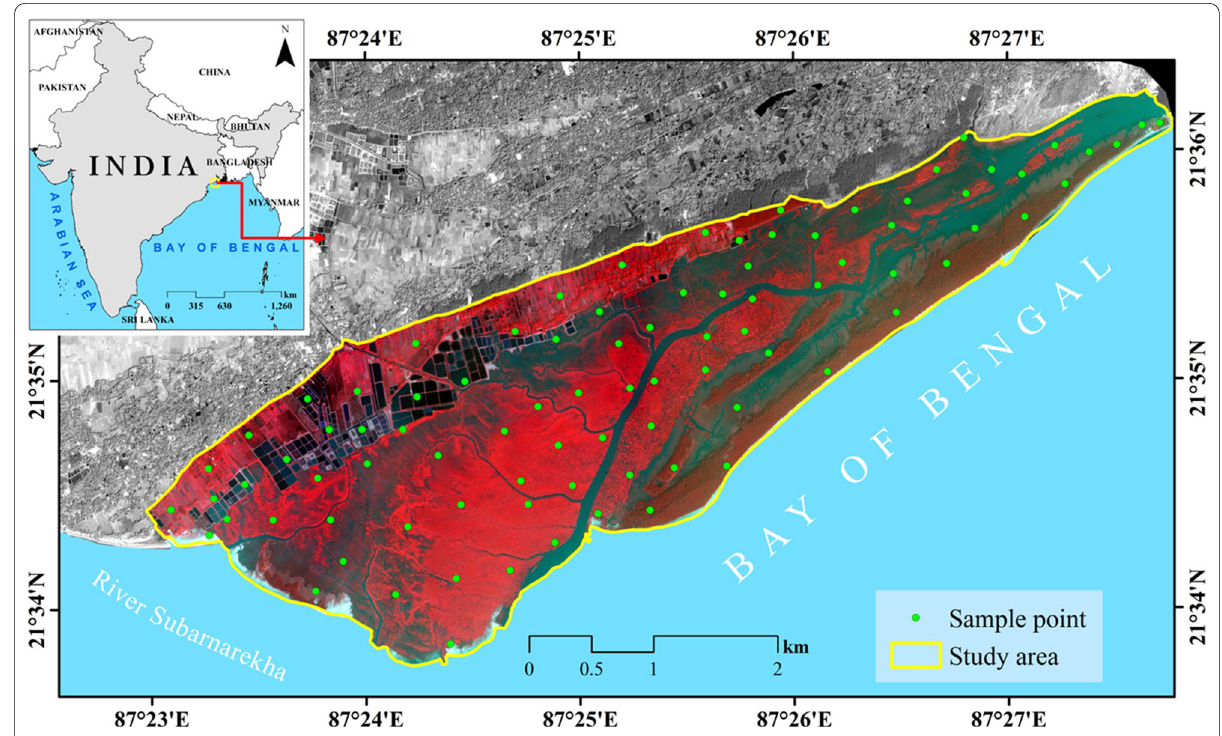
Fig. 1 Location of the wetland influence zone of Bichitrapur mangroves with soil sampling points